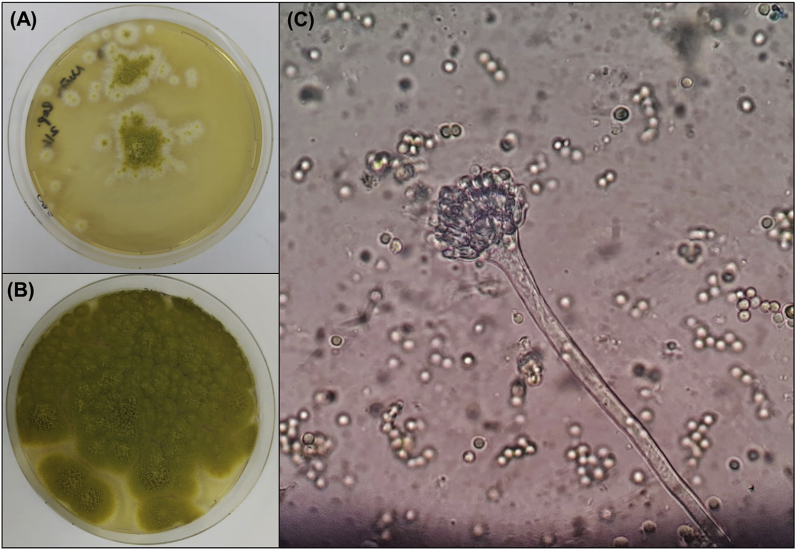
Aspergillus flavus isolate: (A and B) Macroscopic: rapid growth olive green colonies, with woolly texture, on Sabouraud agar incubated at 28 °C (A) and 37 °C (B). (C) Microscopic: hyaline septate hyphae, radiate biseriate conidial head with finely roughened conidiophore. (For interpretation of the references to colour in this figure legend, the reader is referred to the Web version of this article.)